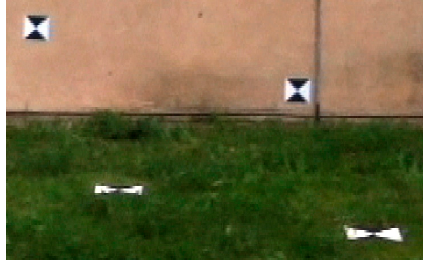
Figure 5. A part of a video image with targets placed on two surfaces: the building wall and on the ground. The terrestrial photogrammetric network consisted of 24 control points and 10 check points.